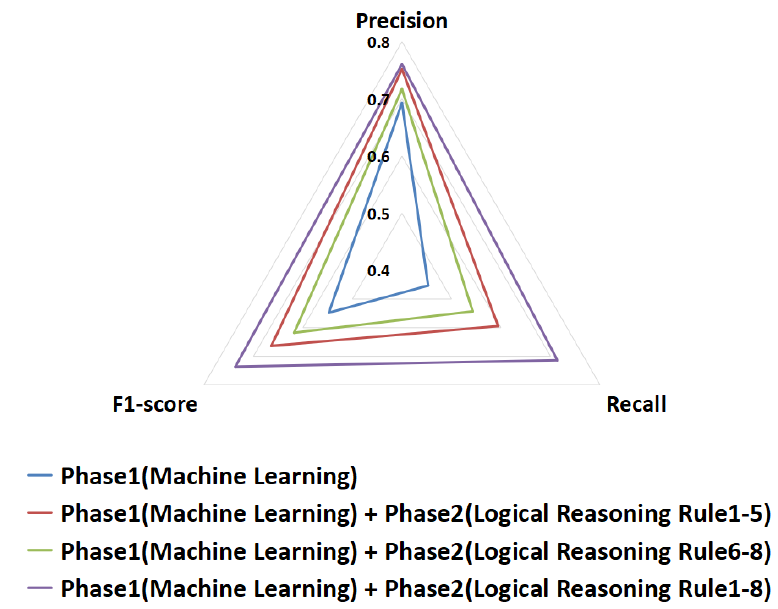
Figure 15. Comparison of different combinations of our proposal on the SMOS